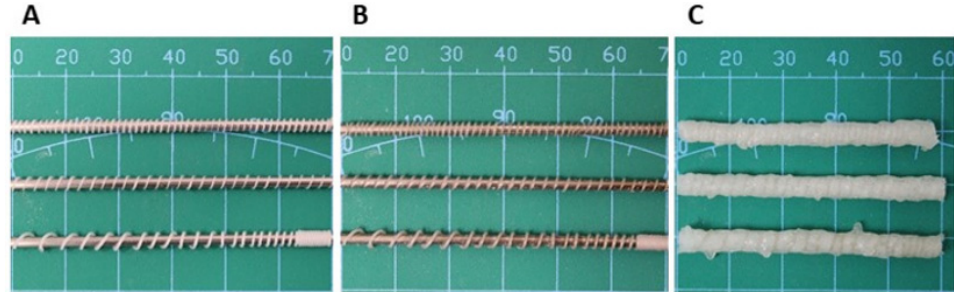
Figure 4. ( A ) PCL helix can be extruded with predefined geometry, constant or gradient pitch. ( B ) NGF-loaded microspheres can be successfully adsorbed to PCL helix covered by dopamine. ( C ) NGF- µ S/PCL helix can be covered by chitosan hydrogel deposit in the process of elec- trophoretic